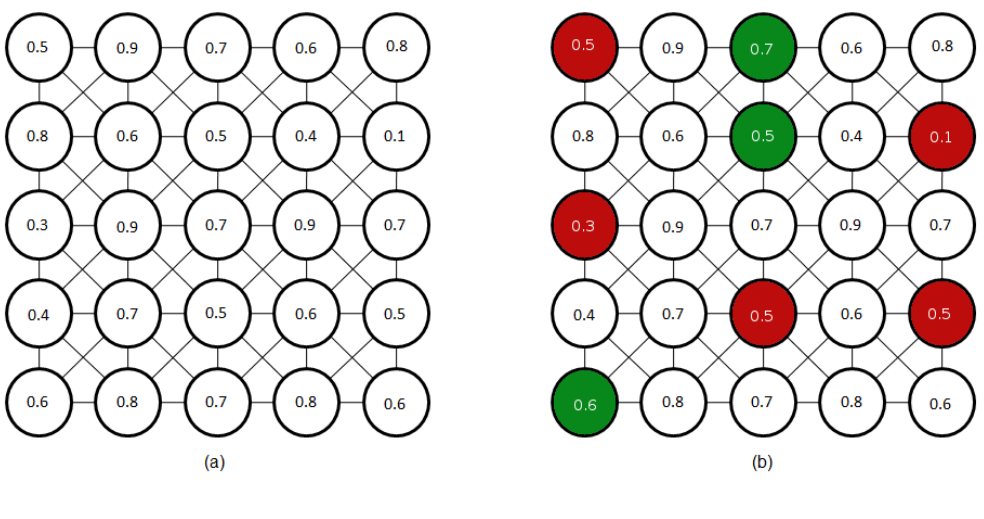
Figure 9. ( a ) Original graph (within each vertex, we have annotated its v i value); and ( b ) surviving vertexes marked in red (local minima) and